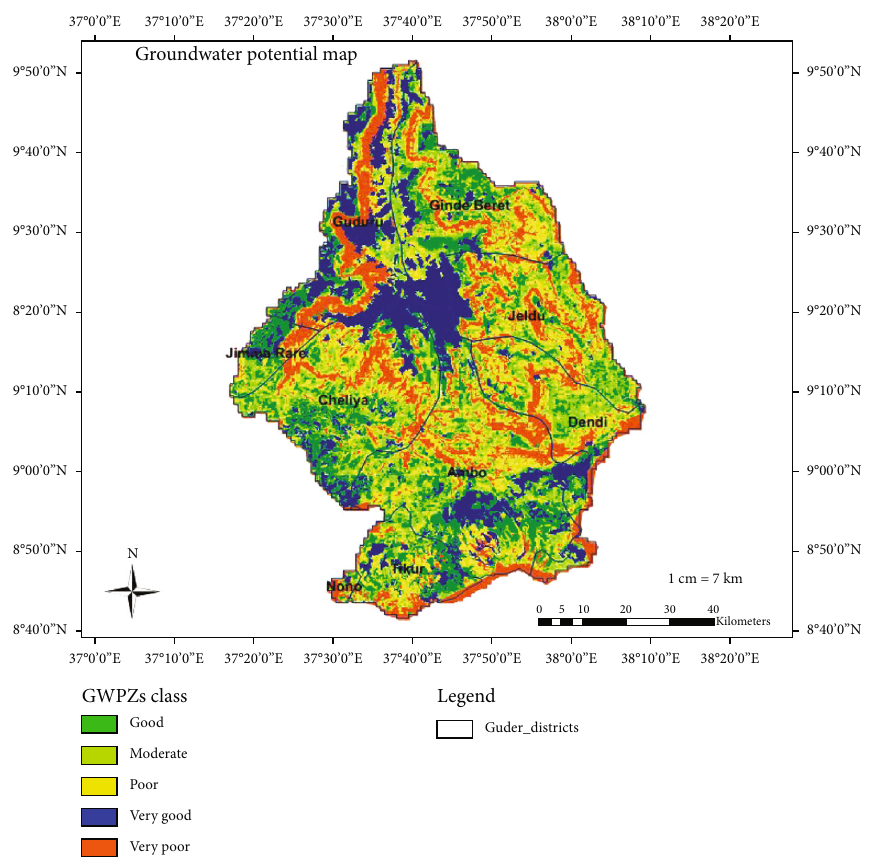
Figure 15: Map showing groundwater potential zones over the study area (districts). Table 6: Pearson pairwise correlation of in fl uencing